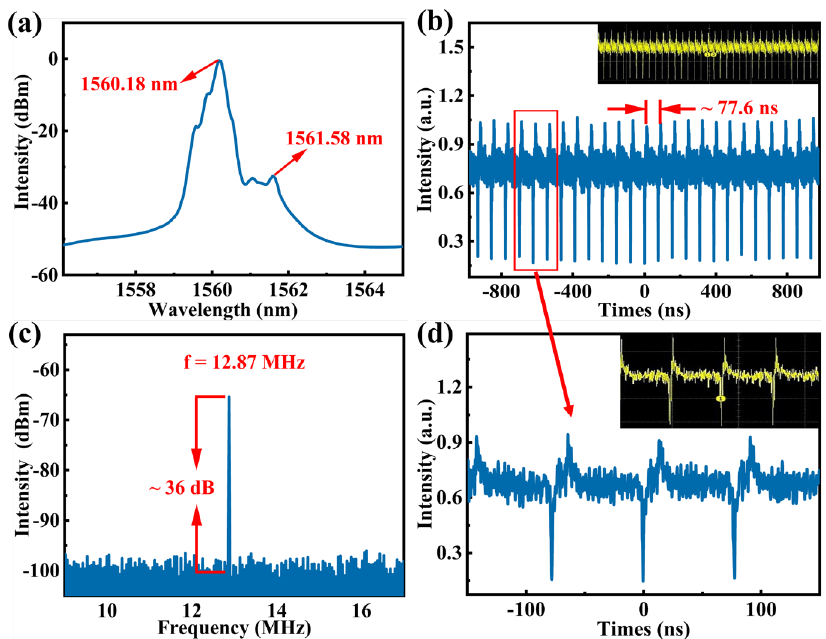
Figure 8. Typical mode-locked pulse output characteristics of the EDF laser based on 2D Bp/InSe SA. ( a ) Optical spectrum. ( b ) Pulse train. ( c ) Radiofrequency (RF) spectrum. ( d ) The pulse train with the span of 300 ns.